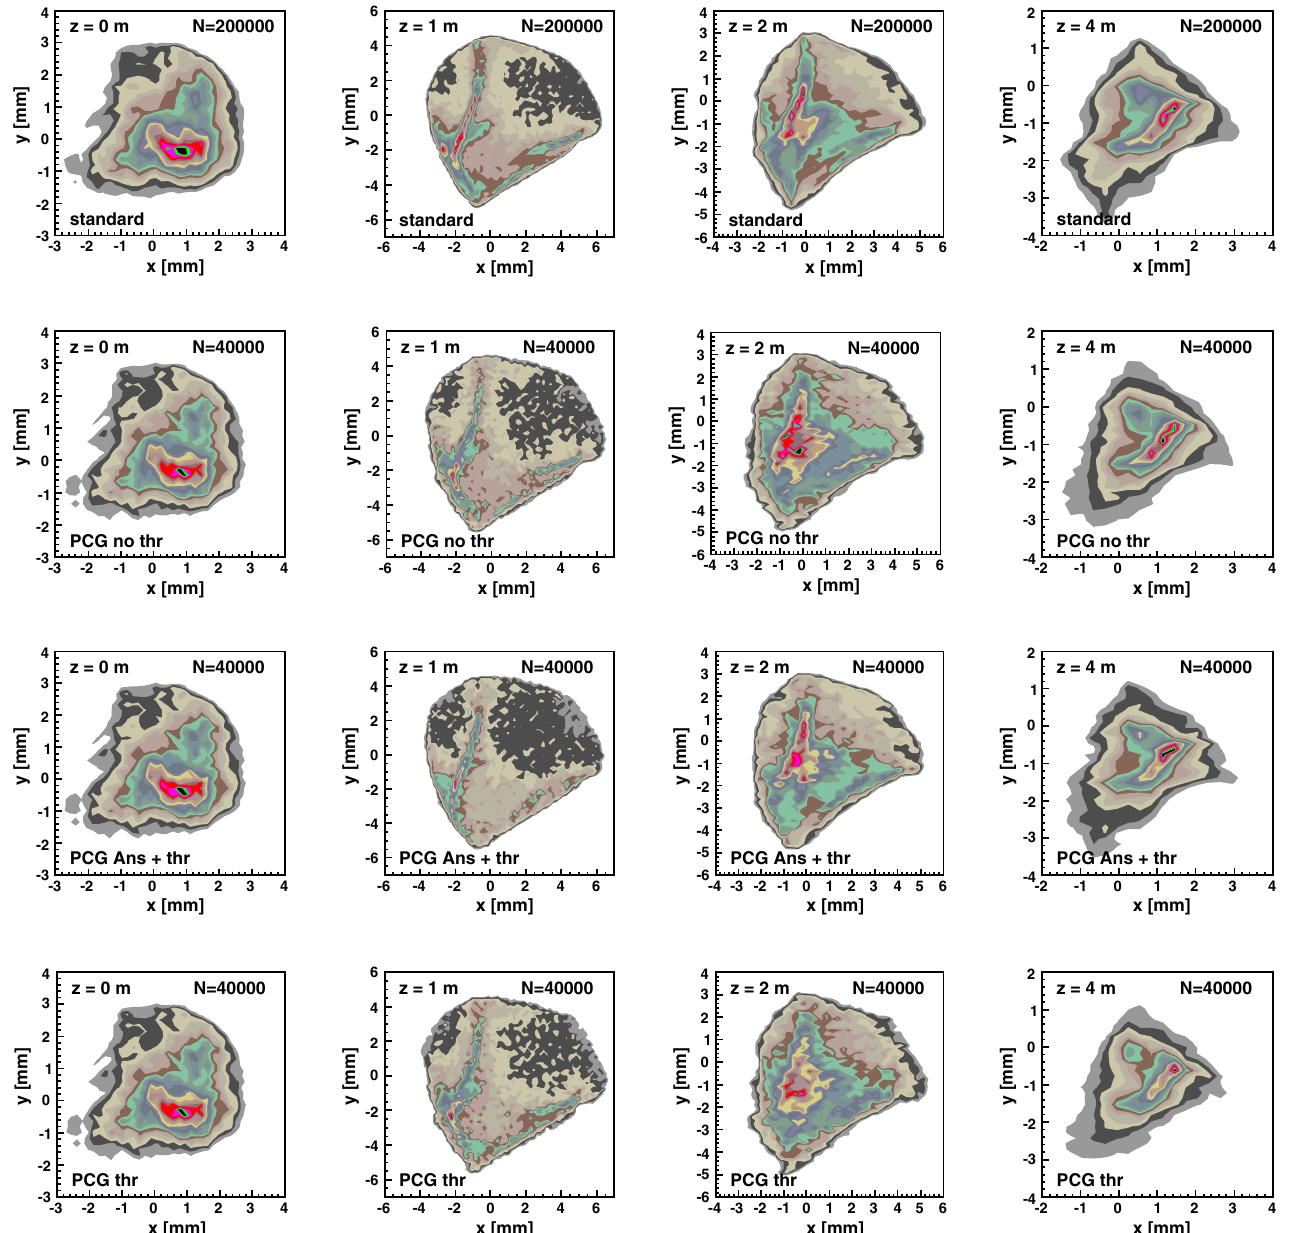
FIG. 15. (Color) Distribution 1 : Integrated transverse cross section of the beam at different positions down the beam line for Fermilab/ NICADD photoinjector simulations with FFT-based IMPACT-T with N (cid:4) 200 000 (first row), and IMPACT-T with PCG with N (cid:4) 40 000 : with no thresholding (second row), with Anscombe transforms and thresholding (third row), with thresholding (fourth row). The first column shows the transverse cross section of the beam leaving the cathode, second at z (cid:4) 1 m , third at z (cid:4) 2 m , and fourth at z (cid:4) 4 m . (cid:4) 32 . Daubechies wavelets of order 2 are Grid resolution is N i